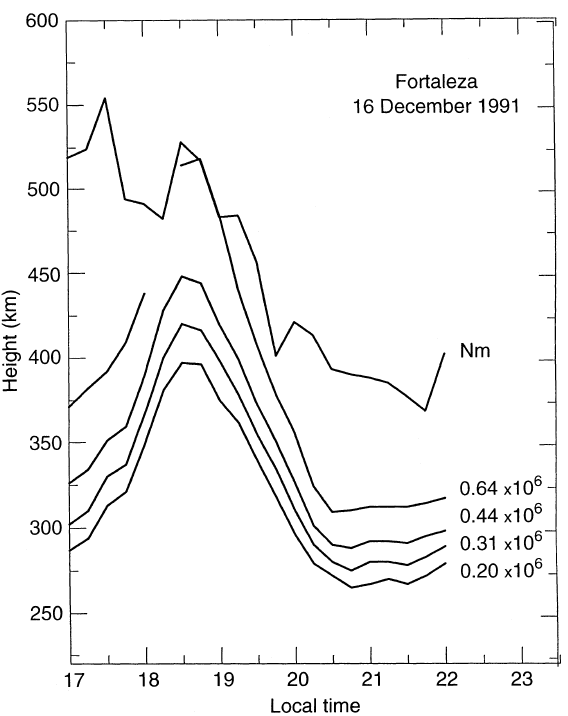
Fig. 3. Height versus time plots of specific electron density levels at Fortaleza for the period 1700–2200 LT on 16 December 1991 as derived from N -h profile data. Note the rapid drop in the height of e isodensity contours over the interval